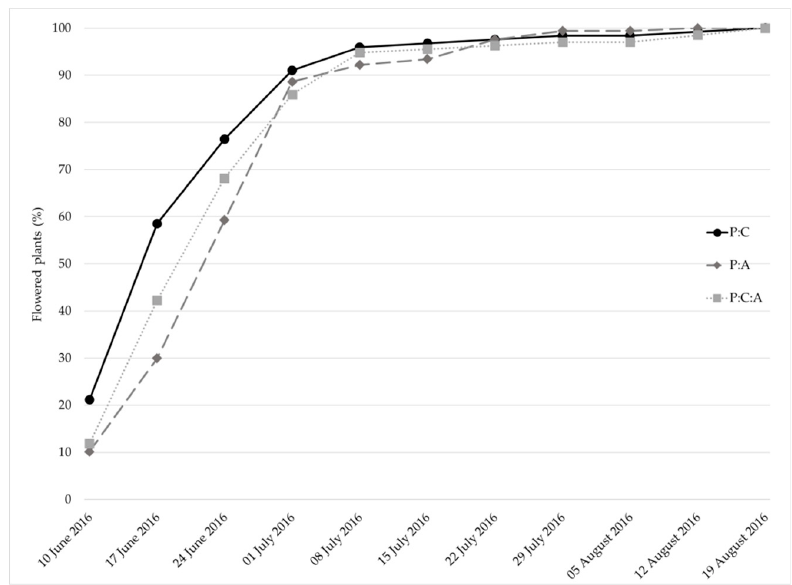
Figure 1. Blooming trend per week of Lavandula angustifolia plants after two cultivation cycles in different substrates (P:C = peat and green compost, 70%:30% v / v ; P:A = peat and demolition aggregates, 70%:30% v / v ; P:C:A = peat, green compost and demolition aggregates, 40%:30%:30% v / v ).